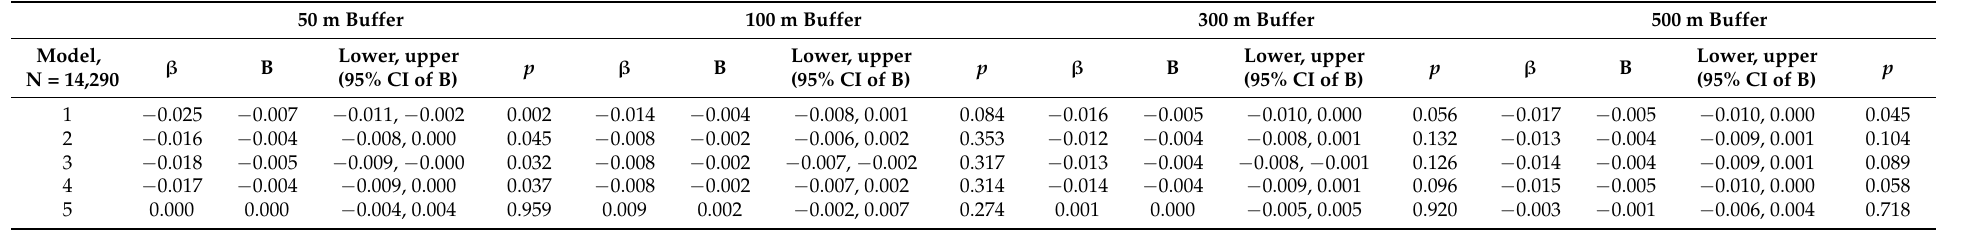
Table 2. Associations between residential greenspace at 50 m, 100 m, 300 m, and 500 m buffers, and depressive symptoms (whole sample/population). 50 m Buffer 100 m Buffer